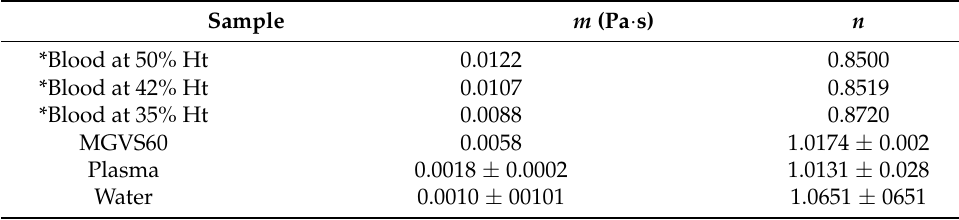
*Blood viscosity values presented at γ(cid:4662) = 1.